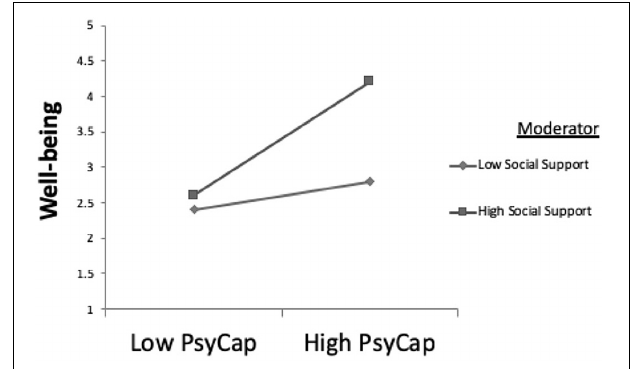
FIGURE 3 | The moderating effect of social support on PsyCap–Well-being relationship (total